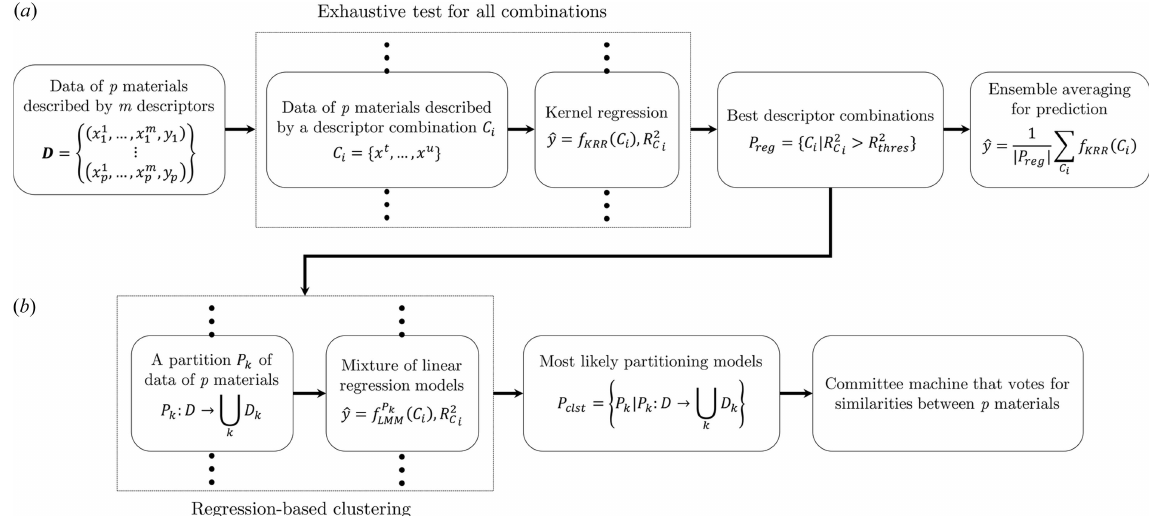
Figure 1 The data flow in our proposed method to measure similarity between materials, focusing on specific target physical properties and using the MapReduce representation language. The process consists of two subprocesses: ( a ) an exhaustive test for all predicting variable combinations, from which we can select the best combinations yielding the most likely regression models, and ( b ) a utilization of the regression-based clustering technique to search for partition models that can break down the data set into a set of separate smaller data sets, so that each target variable can be predicted by a different linear model. We can obtain a prediction model with higher predictive accuracy by taking an ensemble average of the models yielded in ( a ). We use the obtained partitioning models in ( b ) to construct a committee machine that votes for the similarity between